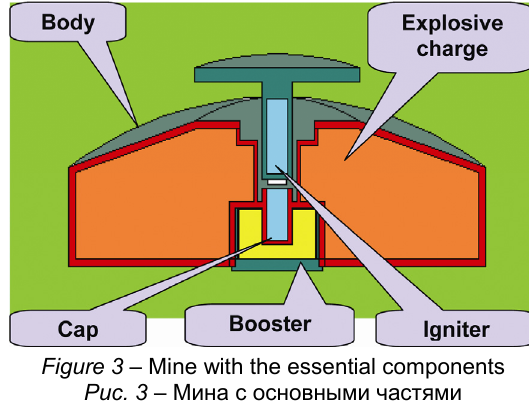
Figure 3 – Mine with the essential components Рис . 3 – Мина с основными частями Слика 3 – Мина са основим